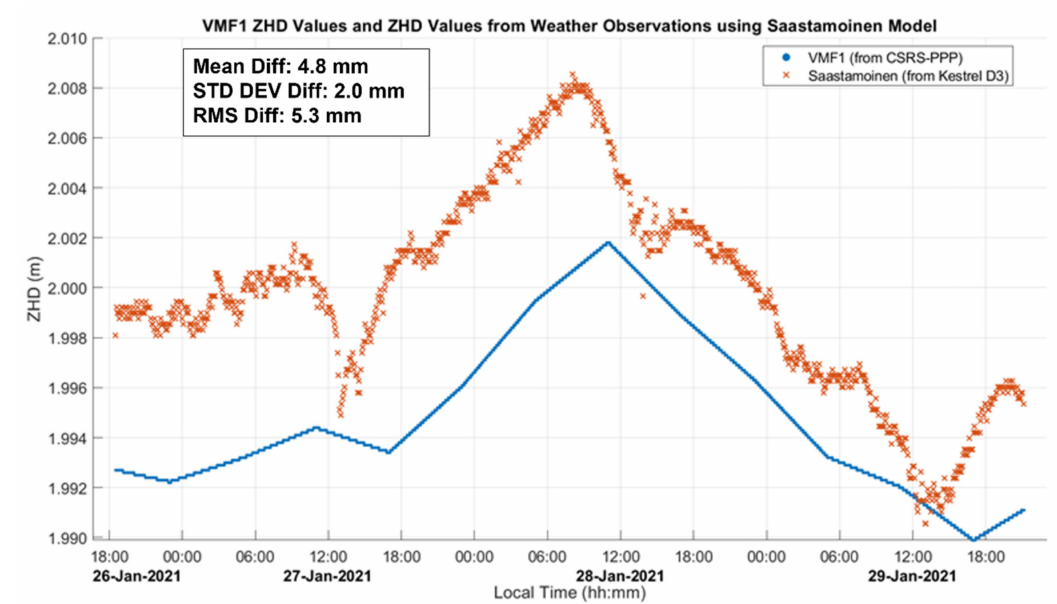
Figure 3. Static dataset A ZHD values produced by the CSRS-PPP using the VMF1 model over a three-day period and compared with values obtained using Saastamoinen’s model and Kestrel unit weather parameters. The six-hour updates of the VMF1 model are evident. The ZHD differences (Saastamoinen’s–VMF1) reach 8 mm and reflect local weather (mostly pressure) variations during the six-hour intervals. Local time is UTC −